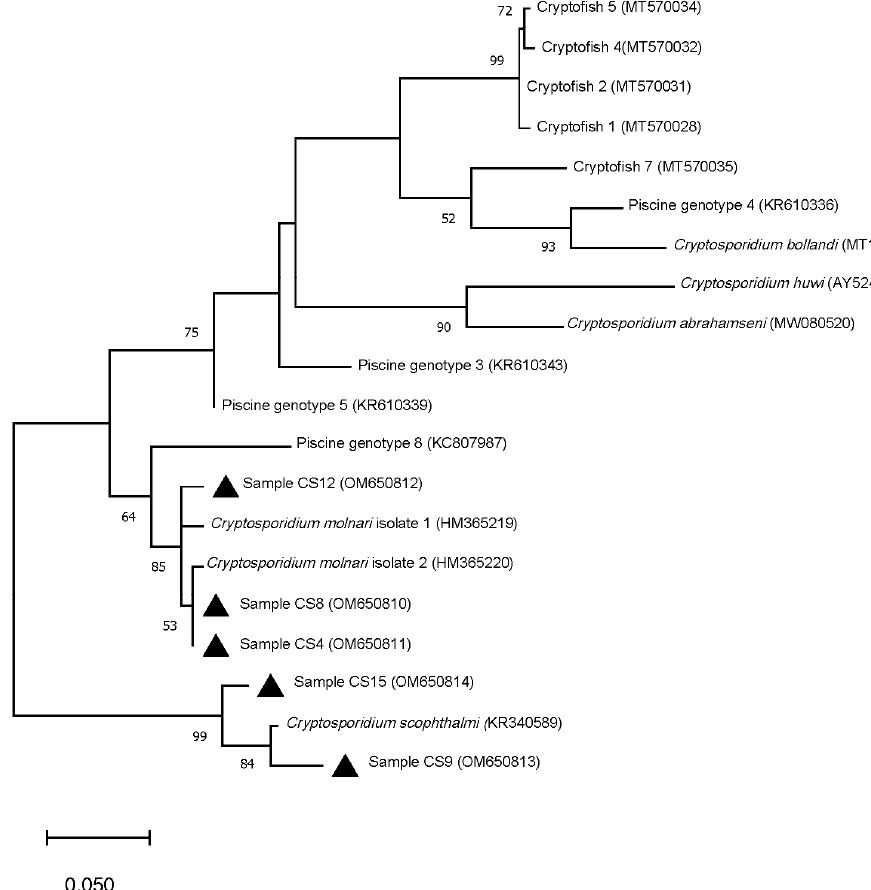
Figure 3. Phylogenetic relationships between Cryptosporidium isolates from this study ( ▲ ) and other Cryptosporidium species and genotypes from fish host inferred by Maximum-Likelihood (ML) method of actin gene sequences (192 bp). Percentage support (>50%) from 1000 replicates (bootstrap test) is indicated at the left of the supported node. Scale bar refers to a phylogenetic distance of 0.05 nucleotide substitutions per site.